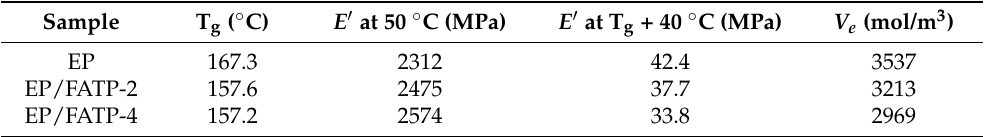
Table 8. DMA data of the pure EP and the FREPs.